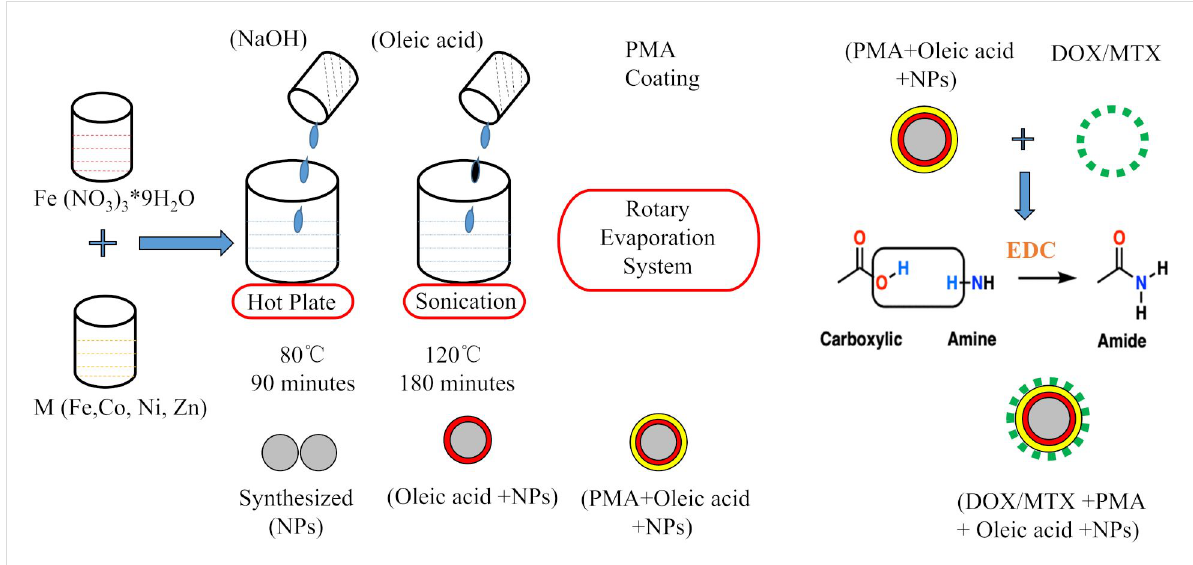
Figure 11: Graphical representation of sonochemical synthesis, PMA-coating, and drug (DOX and MTX) functionalization of MFe 2 O 4 (M = Fe, Co, Zn, Ni) NPs.